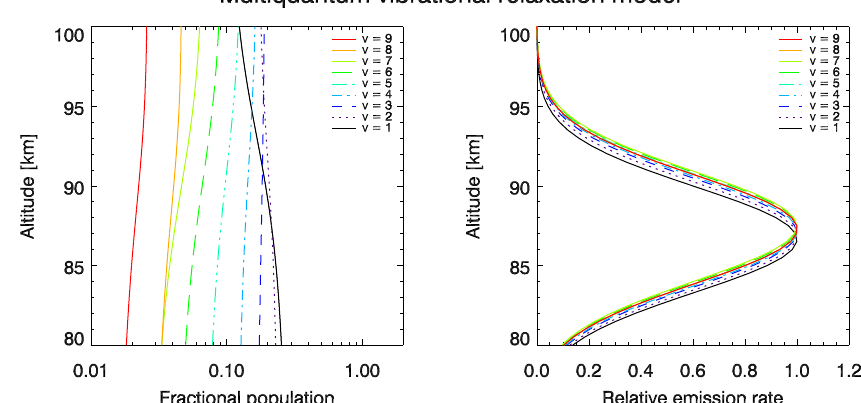
Fig. 7. Fractional population of different vibrational levels (left panel) and modelled vertical emission rate profiles (right panels) for the same parameters as in Fig. 6, except that quenching by atomic oxygen is entirely neglected.